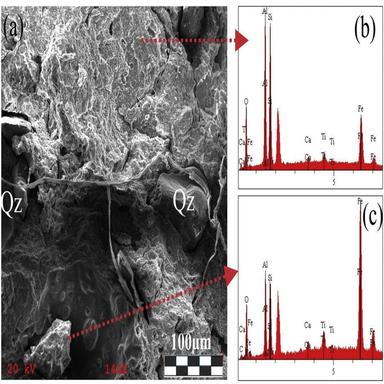
(a) Curtain of the N. Sra. da Conceição bulwark, where IST rocks are observed to be dispersed in a line; (b) Photomicrograph of an IST fragment (sample SJ.R.01/15: face of N. Srª. da Conceição bulwark), in which very fine and poorly selected quartz grains are immersed in a ferruginous matrix.